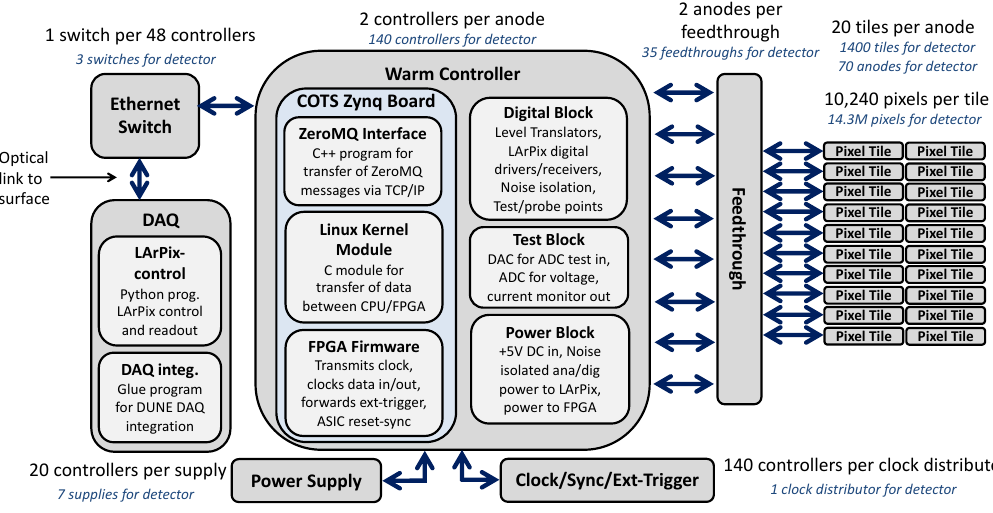
Figure 8. The LArPix system architecture for the ND-LAr